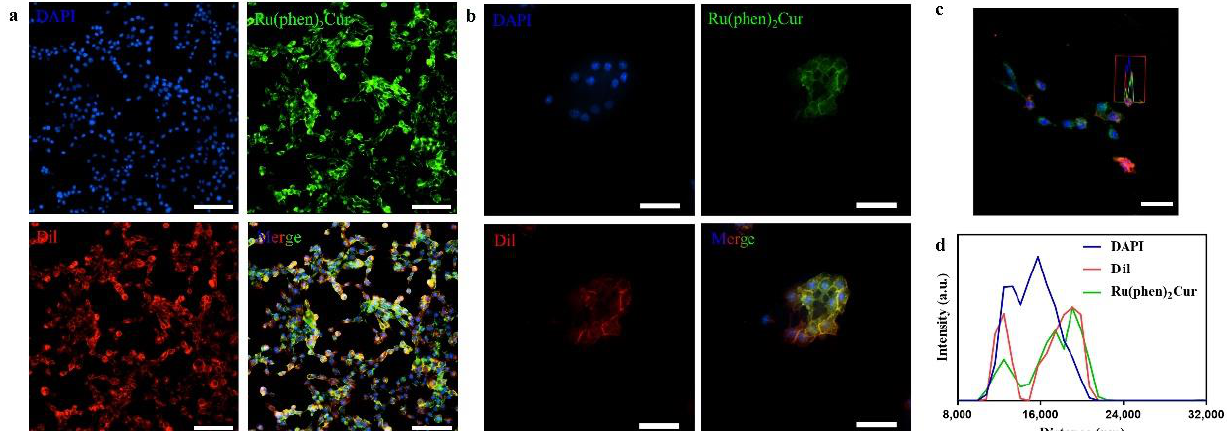
Figure 5. Luminescence confocal microscopy images of 4T1 cell membrane. ( a ) Fluorescence imaging of 4T1 cells stained with DAPI (blue), Ru(II)-coumarin complexes (green) and Dil (red). Scale bar: 100 μm. ( b ) Fluorescence imaging of 4T1 cells stained with DAPI (blue), Ru(II)-coumarin complexes (green) and Dil (red). Scale bar: 50 μm. ( c ) Fluorescence imaging of 4T1 cells stained with DAPI (blue), Ru(II)-coumarin complexes (green) and Dil (red). Scale bar: 100 μm; ( d ) The line scanning profiles of the fluorescence intensity in the corresponding confocal images in ( c ).